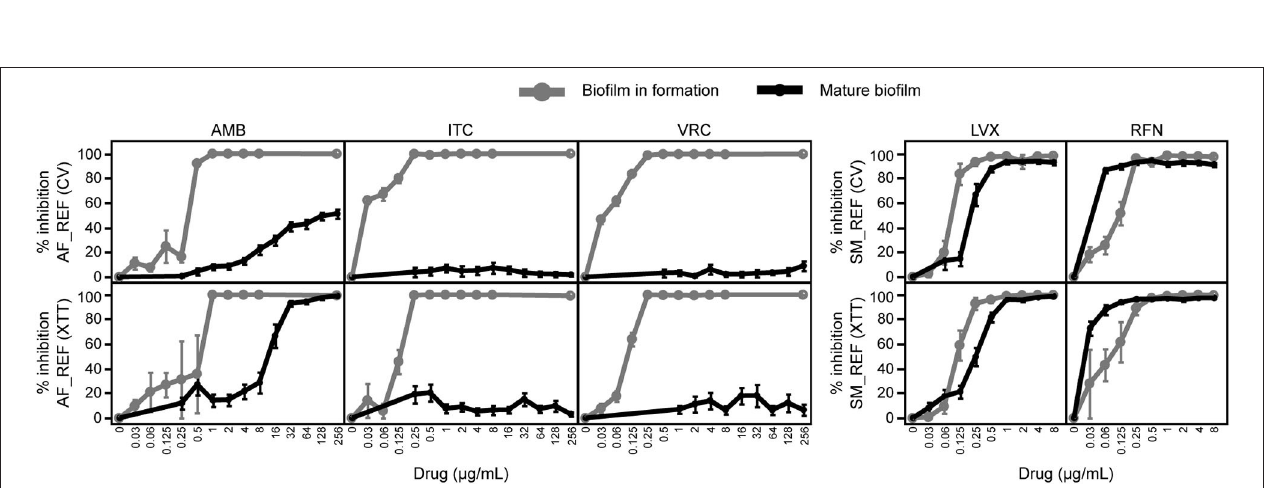
FIGURE 2 | Susceptibilities of biofilms in formation and mature biofilms to drugs. The biomasses and the metabolic activities of biofilms were measured by CV and XTT methods, respectively. Results were expressed in percentages of AF_REF or SM_REF inhibition after antimicrobial treatment compared with untreated controls. AMB, amphotericin B; ITC, itraconazole; VRC, voriconazole; LVX, levofloxacin; RFN,